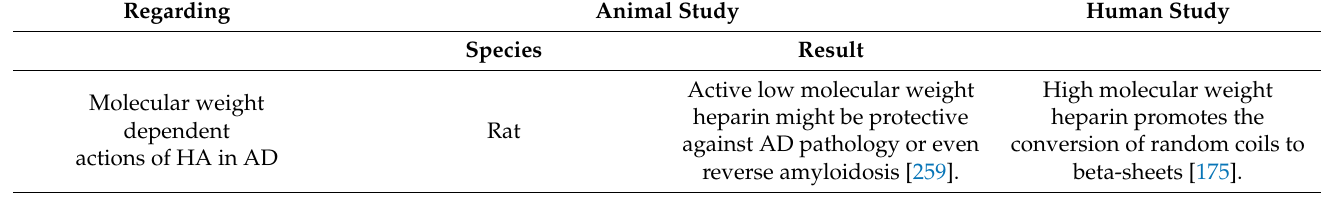
Table 2. Role of brain extracellular matrix molecules—results gained from human versus animal